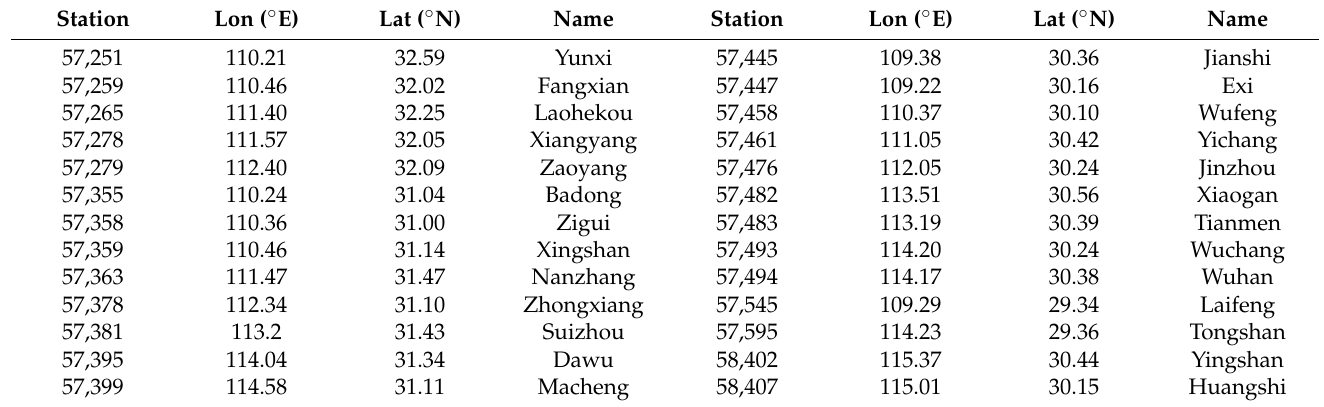
Figure 1. Distribution of meteorological stations and prefecture-level cities in Hubei Province. Table 1. Basic information of meteorological stations in Hubei Province.